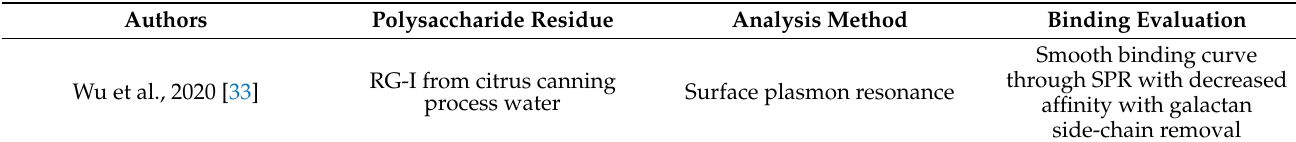
Table 1. Polysaccharide-Gal-3 binding articles